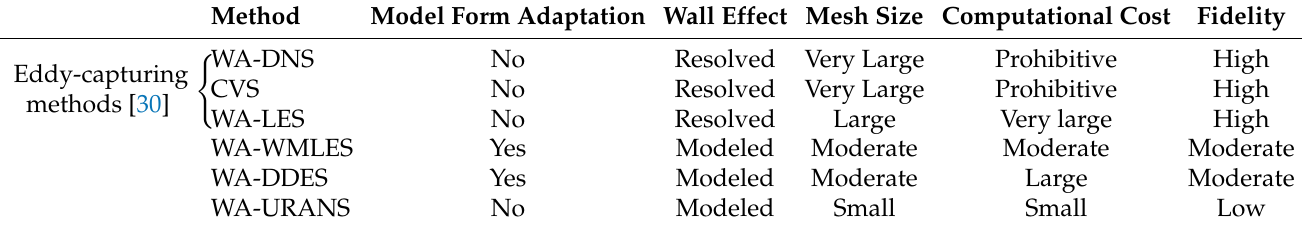
Table 5. Summary of wavevet-based adaptive eddy-resolving methods for wall-bounded compressible turbulent flows.